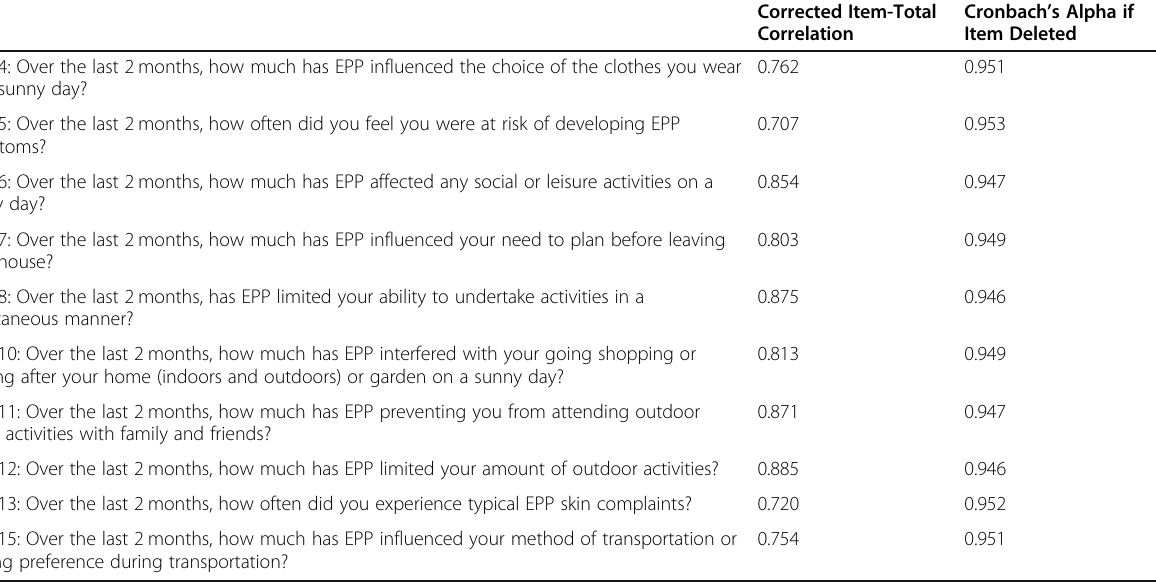
Table 4 Item-total correlations and Cronbach ’ s alpha with item deletion for the EPP Symptoms score (Cronbach ’ s alpha for scale = 0.954) from Visit 3